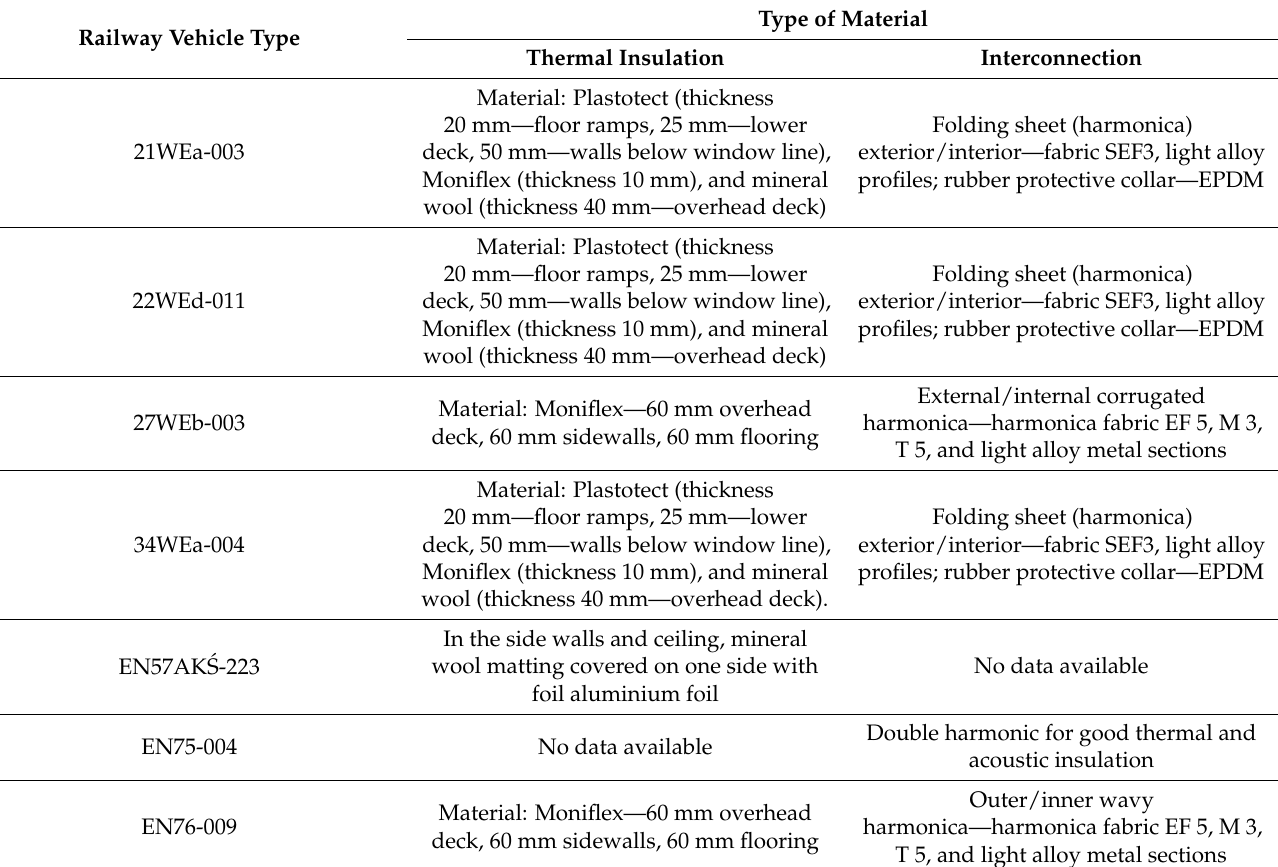
Table 3. Technical characteristics of materials used in railway